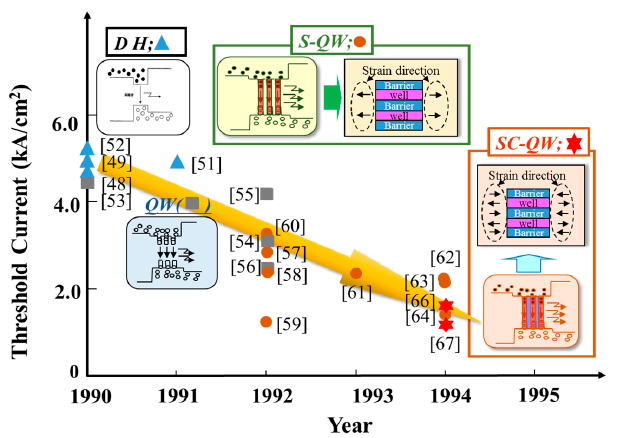
Figure 6. Development history of active layer for 630 nm band AlGaInP laser diodes with transverse mode stabilized structure. Optical guiding structure: optical loss guiding type [59]; Ridge structure [64]: λ /2-High Reflective (HR) facets coating laser.